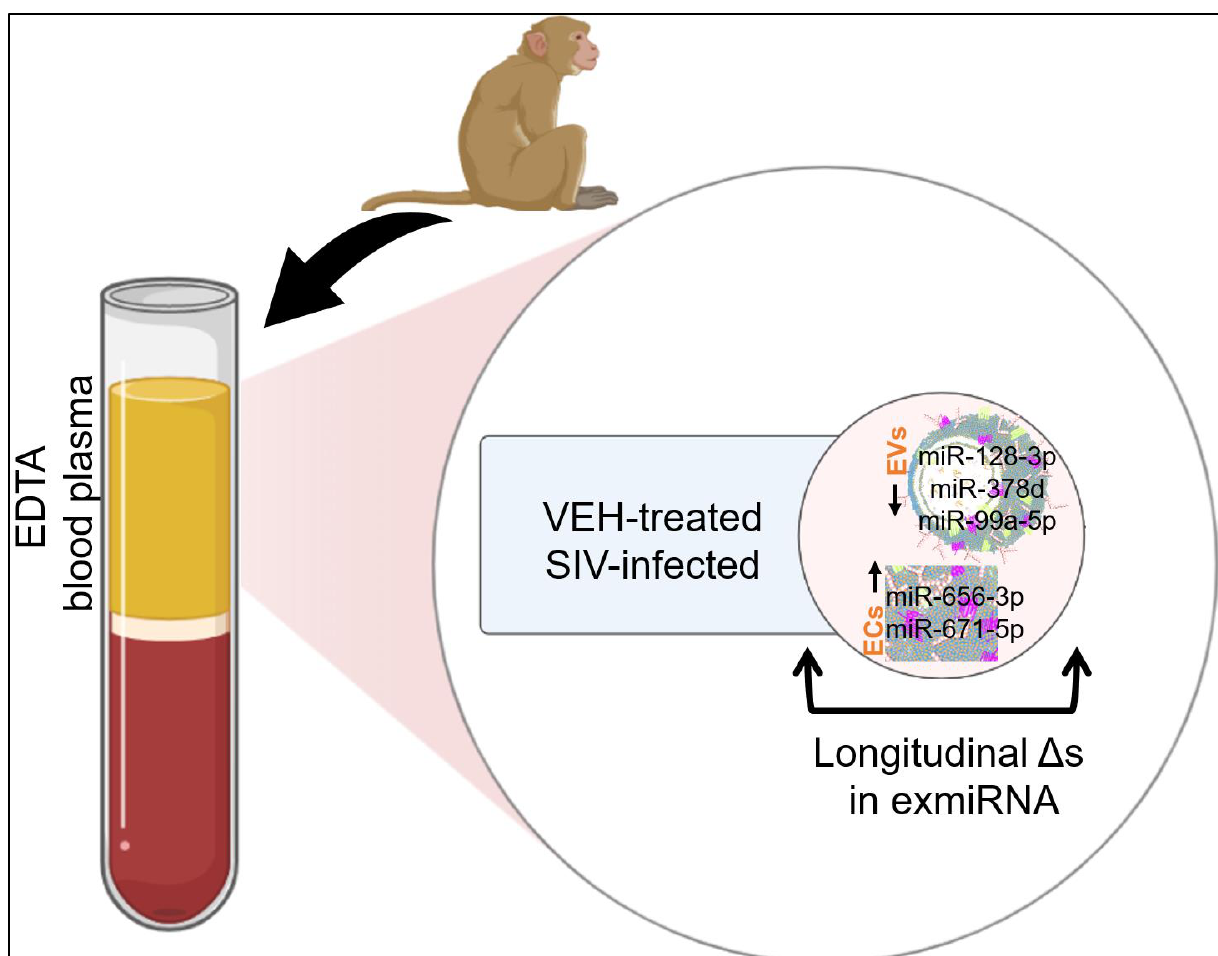
Figure 6. Circulating blood plasma miRNAs and their association with EVs and ECs in uninfected and SIV-infected rhesus macaques. Part of this illustration was created with BioRender.com.